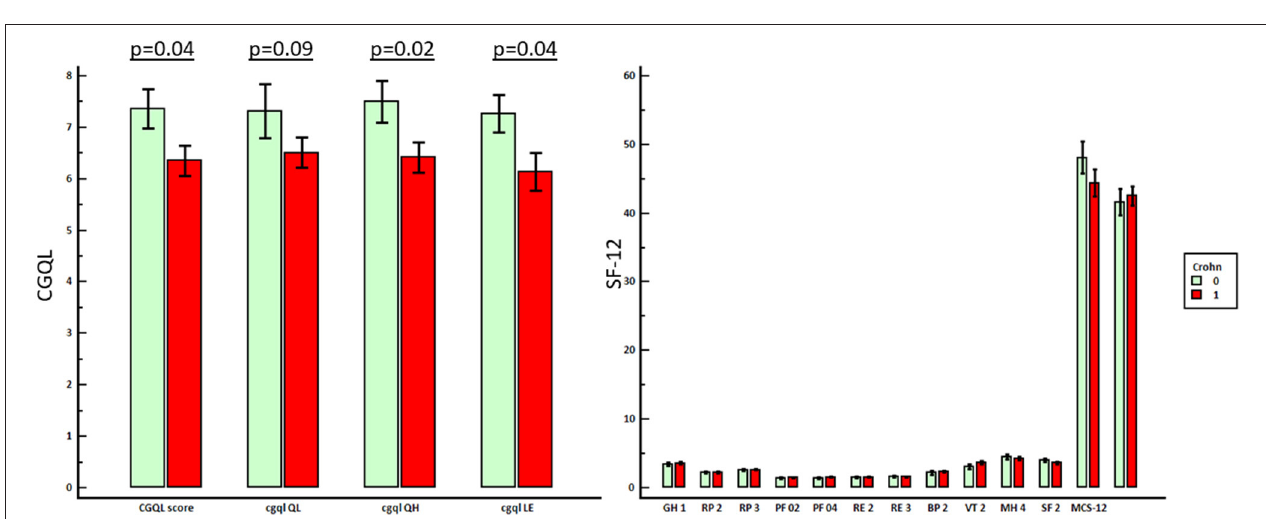
FIGURE 3 | Comparison between the quality of life of patients with perianal CD and patients with sporadic perianal disease.